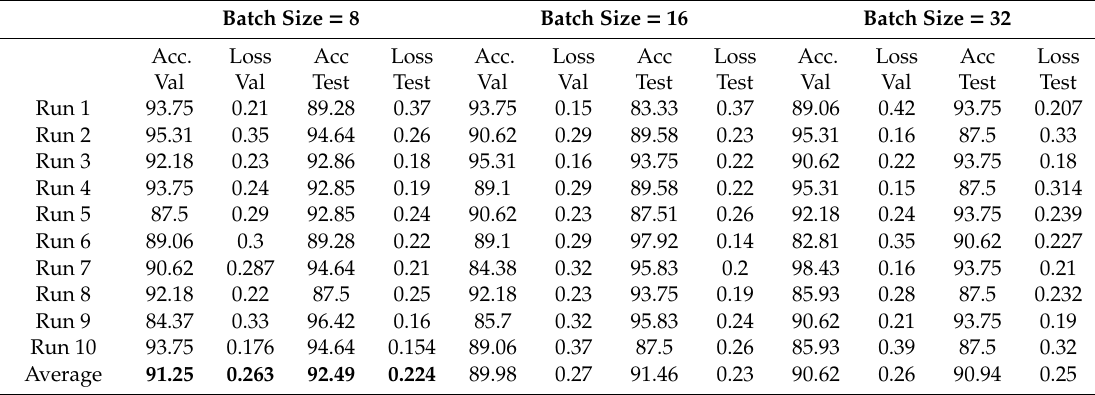
Table 4. CNN model 2 (epochs = 200, dropout = 0.7, pixel = 256 × 256) runs for di ff erent batch sizes.